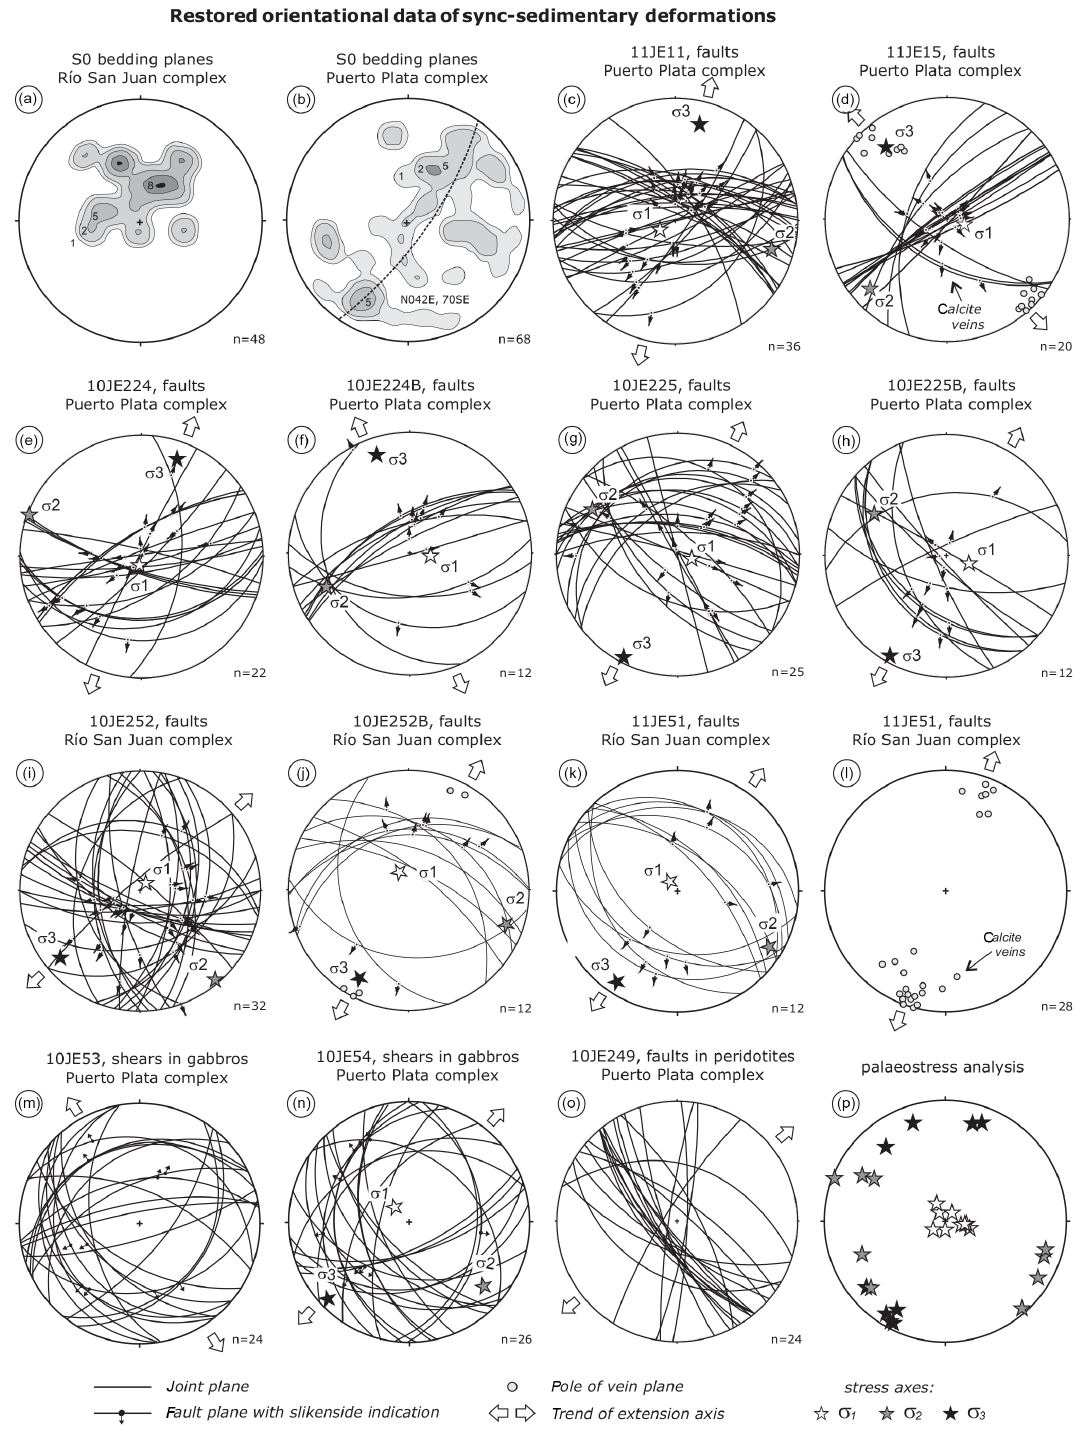
Figure 9. (a, b) Stereoplots of bedding planes (S0) of the Imbert Fm in the Puerto Plata and Río San Juan complexes. (c, o) Stereoplots of fault, joints and calcite veins affecting Imbert Fm deposits from several measurement stations at Puerto Plata and Río San Juan areas. The upper number indicates the station. (p) Stereoplot of stress-axes in all stations. Stereoplots also include the stress-axes obtained from the palaeostress analysis. The white arrows indicate the trend of subhorizontal extension. Equal angle, lower hemisphere projection.